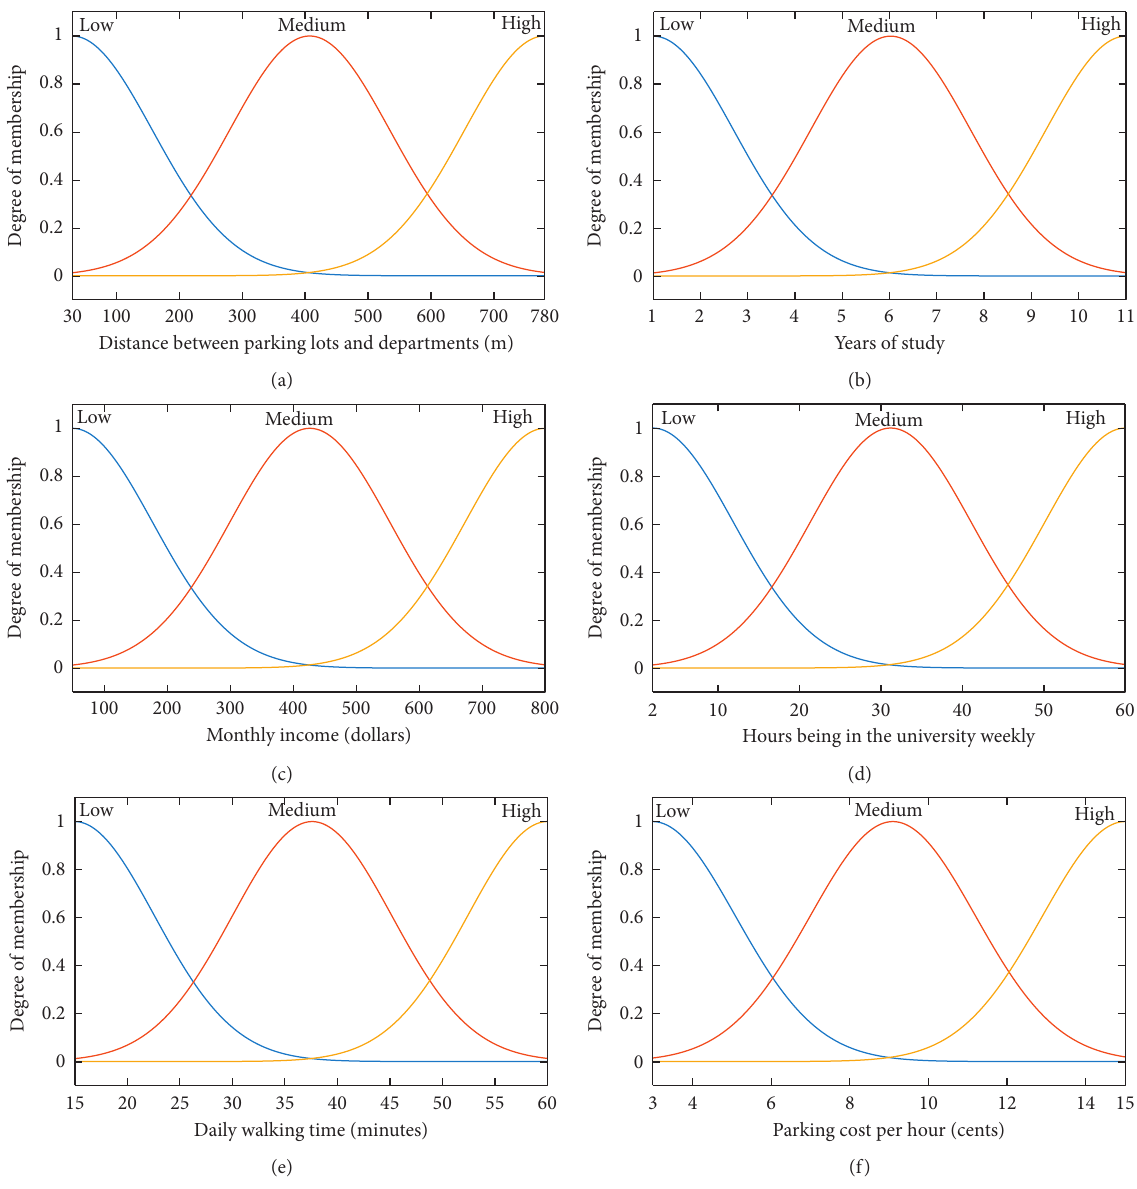
Figure 1: Input membership functions for modelling using fuzzy inference